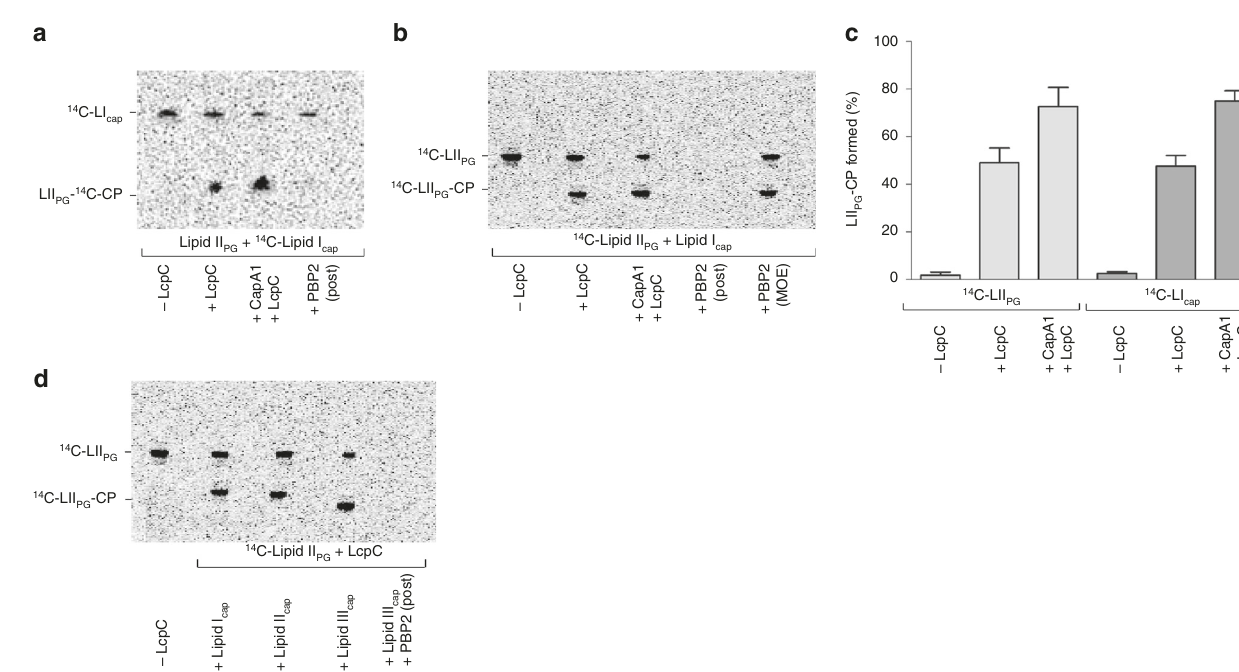
Fig. 5 Attachment of CP to the ultimate PG building block lipid II PG is mediated by LcpC. a [ 14 C]lipid I cap and lipid II PG or b lipid I cap and [ 14 C]lipid II PG were incubated with LcpC in the absence or presence of CapA1. The resulting reaction product (LII PG -CP; bold) exhibits an altered migration behavior on the TLC compared to the individual substrates, lipid II PG and lipid I cap . PBP2 catalyzes the transglycosylation of the LcpC reaction product LII PG -CP (lane 4) resulting in the polymerization of radiolabeled lipid II PG -CP into hydrophilic glycan strands that retain in the water phase and are not extracted after BuOH/PyrAc treatment resulting in disappearance of the corresponding band on the chromatogram. The PBP2 catalyzed conversion is inhibited in the presence of the antibiotic moenomycin (MOE; 10 µ M) (B, lane 5). c Quanti fi cation of lipid I cap attachment to lipid II PG . Radiolabeled bands were quanti fi ed by phosphoimaging. Experiments were performed in triplicate. The error bars represent the ± SD from three biological replicates. d LcpC catalyzes the attachment of lipid II cap (lane 3) and the ultimate CP lipid intermediate lipid III cap (lane 4) and the fi nal reaction product is processed by PBP2 added posterior to the LcpC reaction (lane 5). Representative TLC of 2 independent